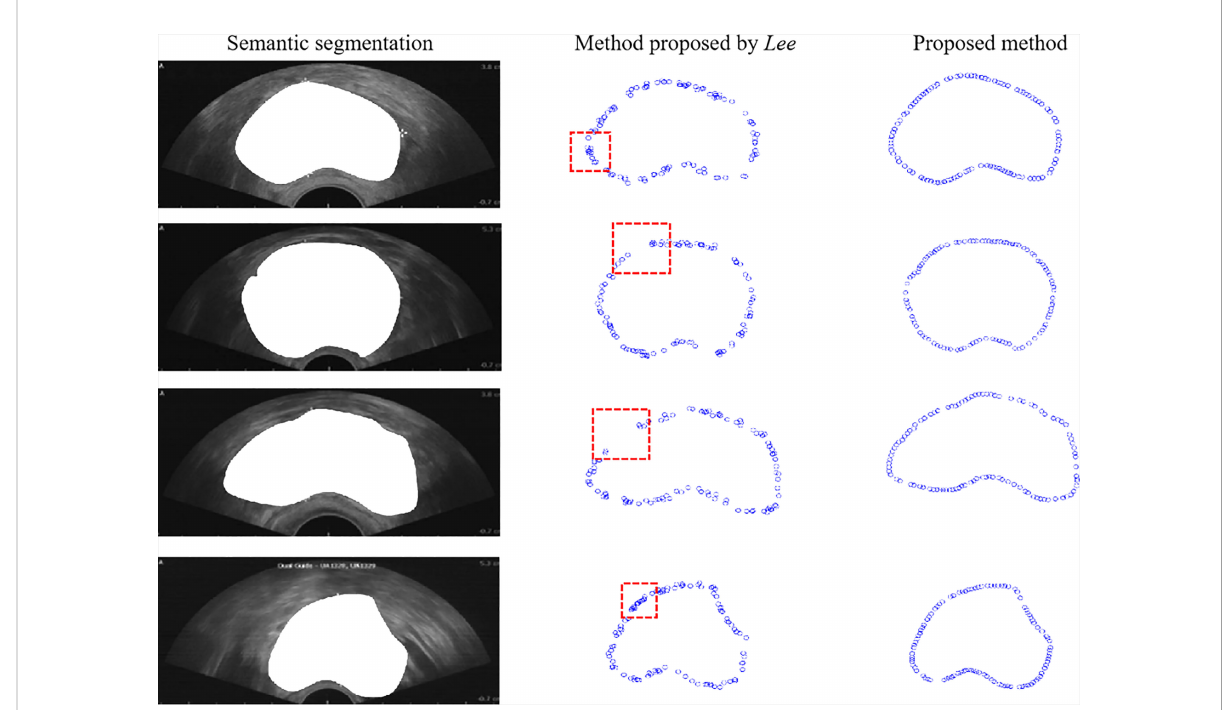
FIGURE 5 Comparison of boundary detection. The fi rst column is the original image, the second column is the boundary detection based on Lee ’ s method, and the third column is the boundary detection based on the proposed